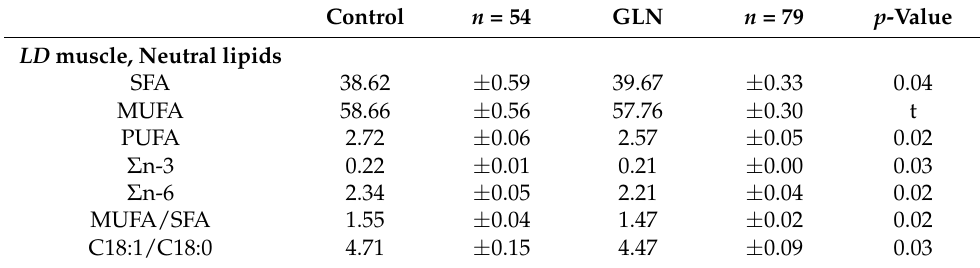
Table 6. Significant differences in the fatty acid (FA) composition of the polar lipid fraction of LD muscle between control and treated (GLN) pigs at the slaughterhouse. LSmean ± SE (g/100 g total FA).